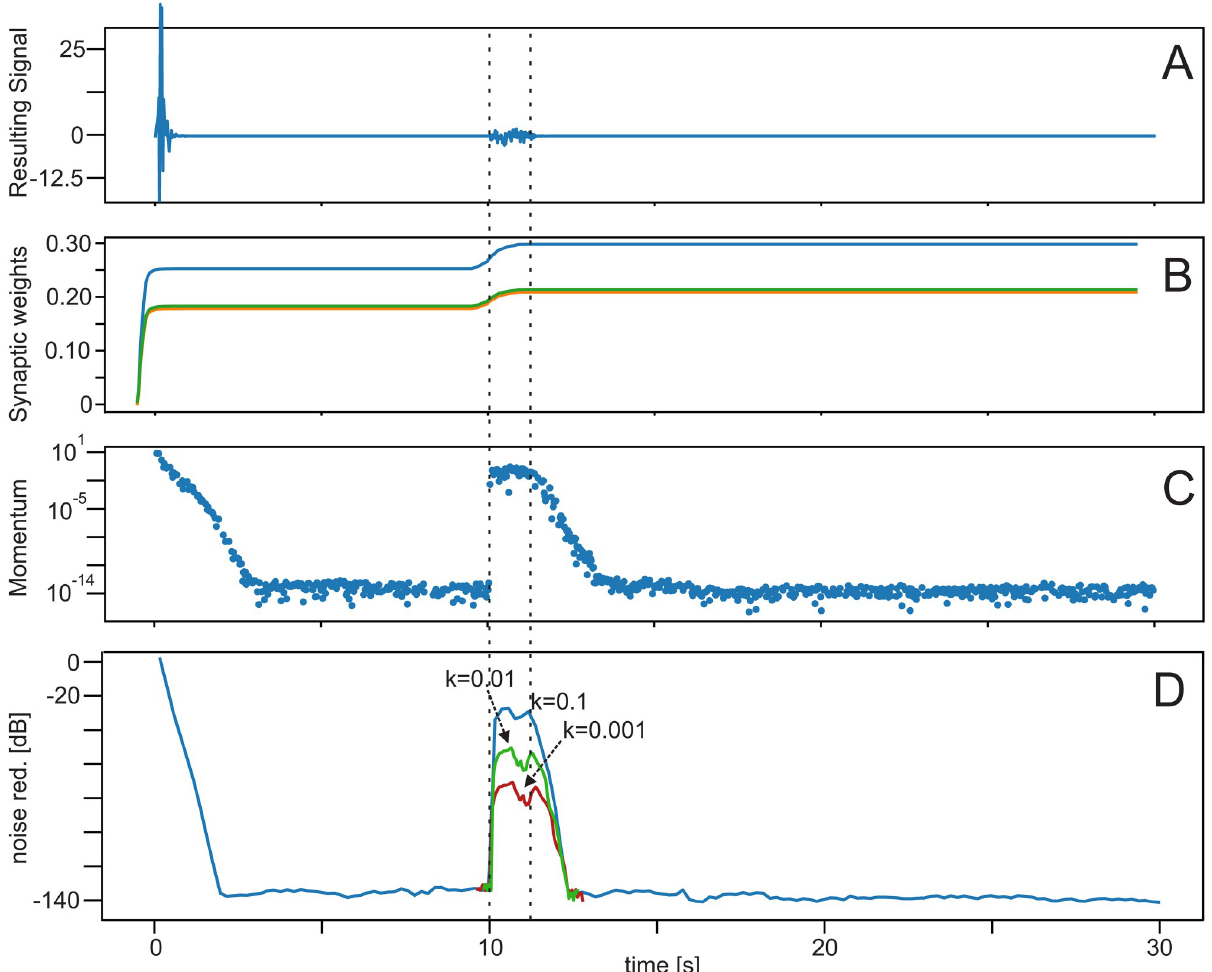
Fig 4. Results for parameter drifts. We used the linear microphone setup from Fig 3B. After 10 s a parameter drift for 1 s has been introduced (dashed lines). (A-C in arbitrary units). Learning rate: μ = 1.0 × 10 − 7 . A effective noise at the reference site. Before the parameter drift this curve is identical to Fig 3B, but here truncated in y-direction to make the effect of parameter drift visible. B weight dynamics, green and orange curves are identical due to the symmetry of the microphone configuration and are here shifted a bit to make both visible, C development of the momentum, and D achieved noise reduction for different drift rates k (only parts of the red and green curves are